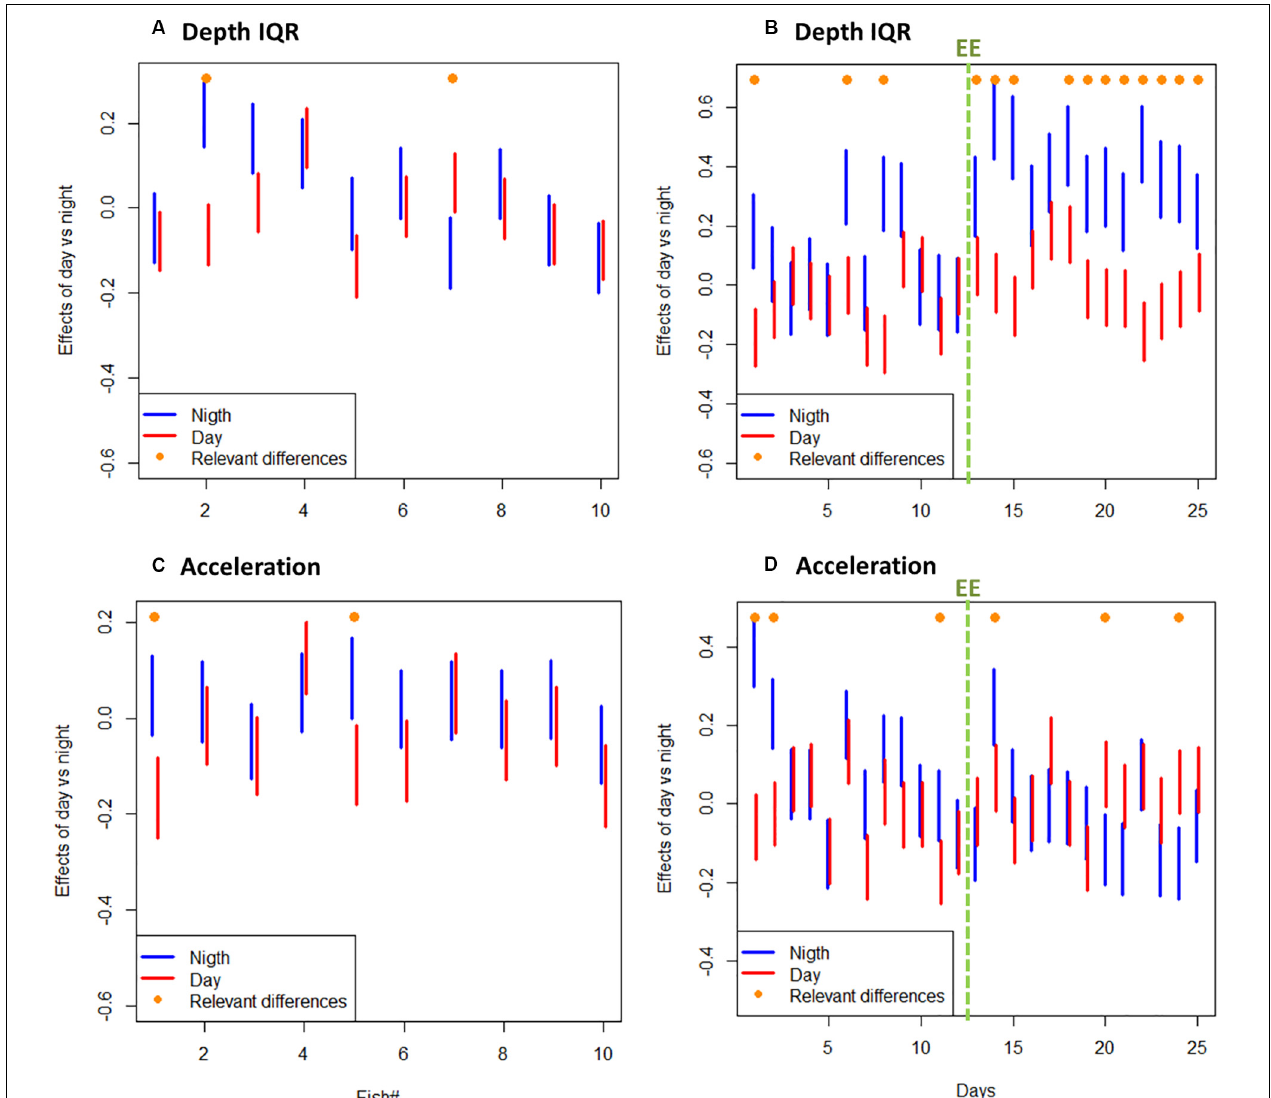
FIGURE 1 | (A) Depth IQR 95% confidence interval (CI) of individual tagged fish during all day and night periods. (B) Depth IQR 95% confidence interval (CI) of all tagged fish ( N = 10) throughout the experiment (in days) during day and night periods. (C) Acceleration 95% confidence interval (CI) of individual tagged fish during all day and night periods. (D) Acceleration 95% confidence interval of all tagged fish ( N = 10) throughout the experiment (in days) during day and night periods. Relevant differences are marked with on-top orange dot. Note: green dashed line represents the beginning of the experimental period with environmental enrichment